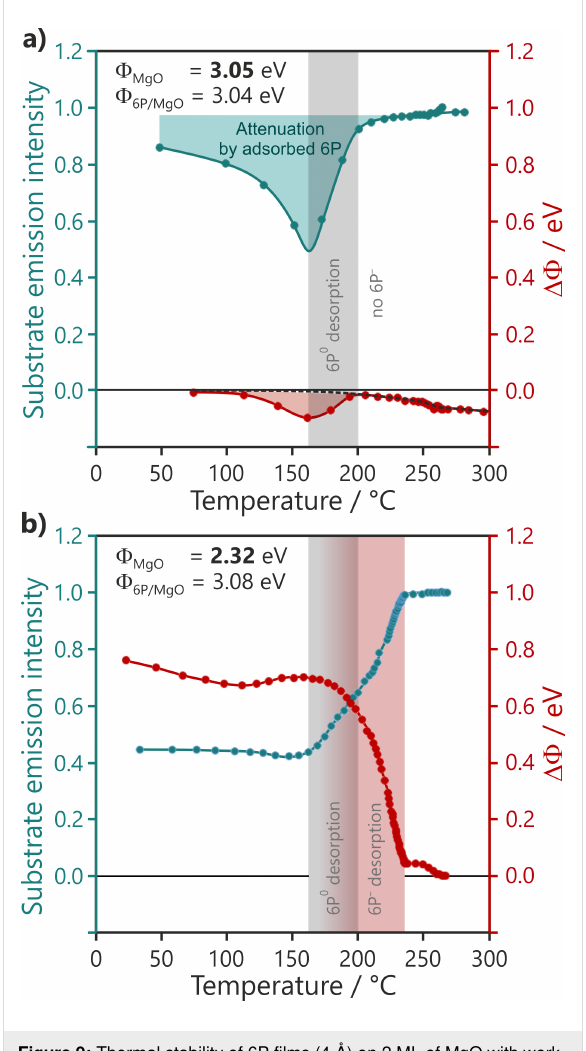
Figure 9: Thermal stability of 6P films (4 Å) on 2 ML of MgO with work functions (a) above and (b) below the critical work function. The blue curves depict the normalized photoemission intensity of the MgO valence band relative to the intensity after 6P film desorption. The red curves depict the change in work function relative to the pristine MgO film work functions, Φ MgO